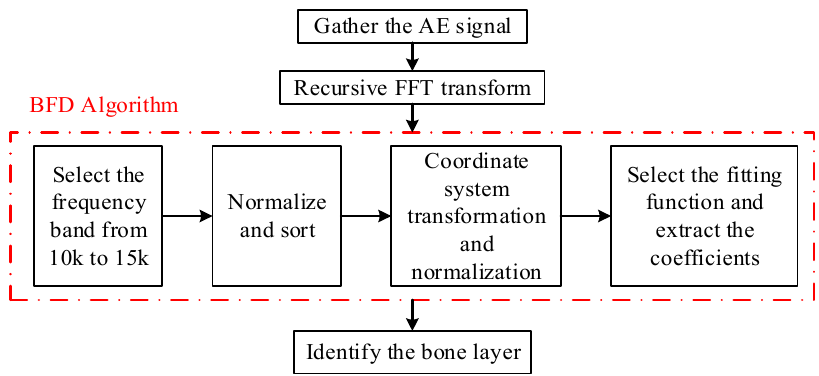
Figure 10. Flow chart of the AE signal process and the proposed FDB algorithm.